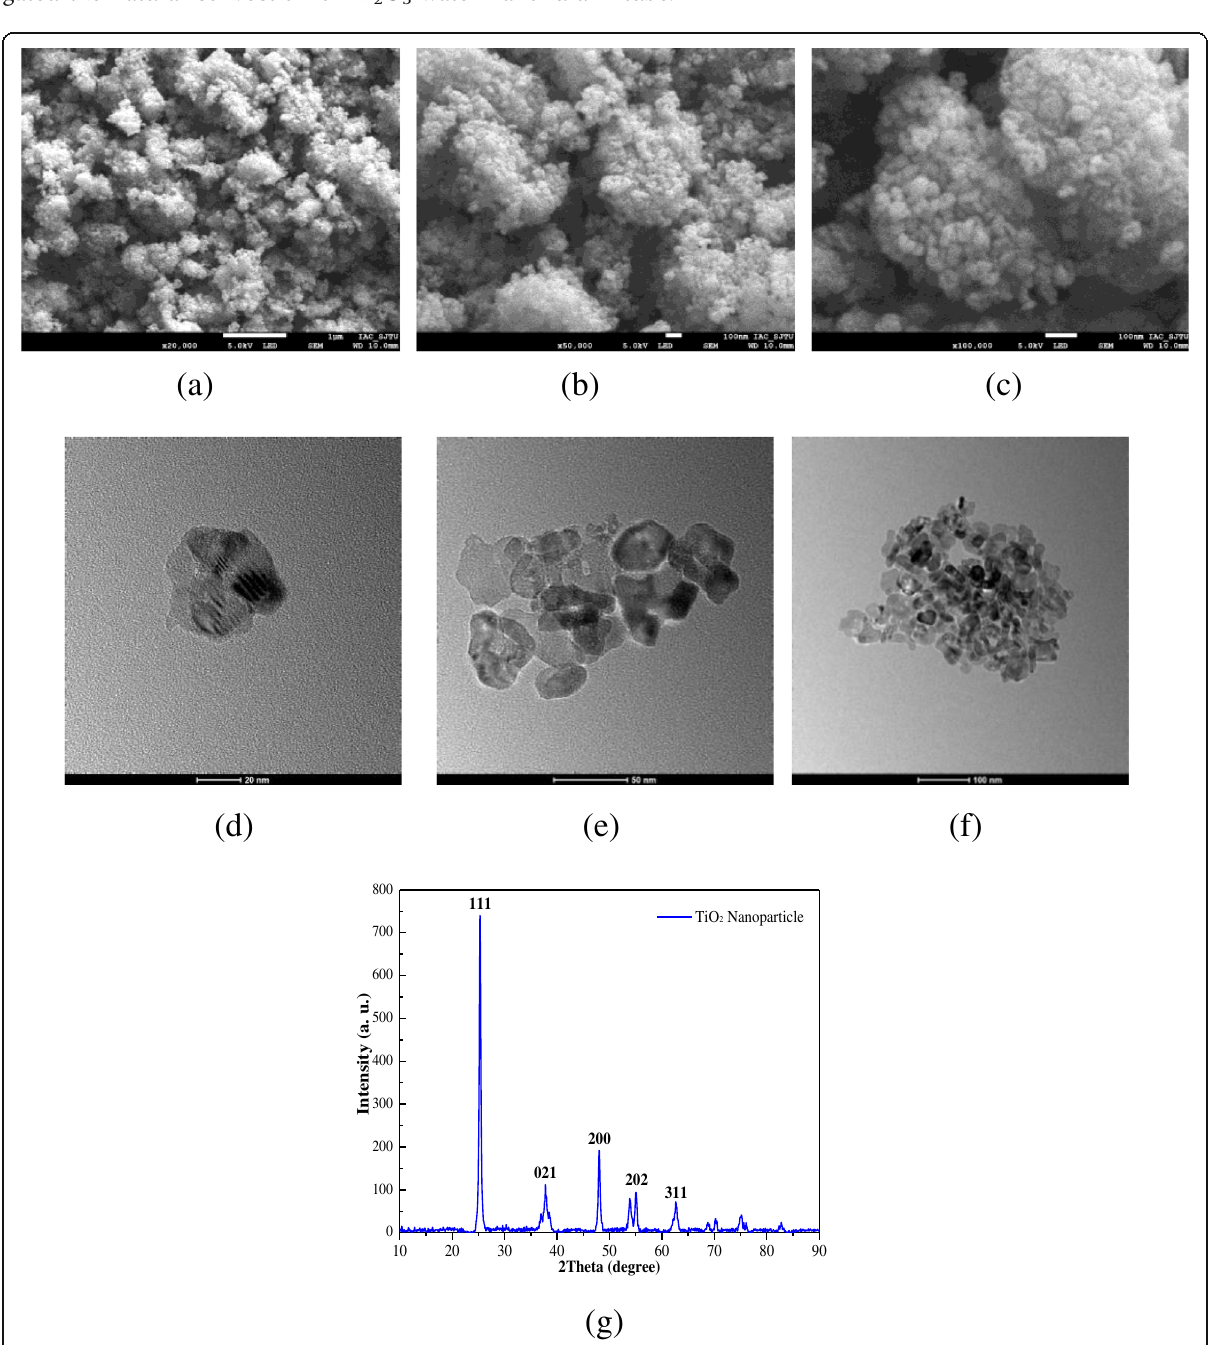
Fig. 1 Morphology of nanoparticles. SEM, TEM, and XRD images of TiO 2 nanoparticles at different magnification times. a SEM×20000. b SEM×50000. c SEM×100000. d